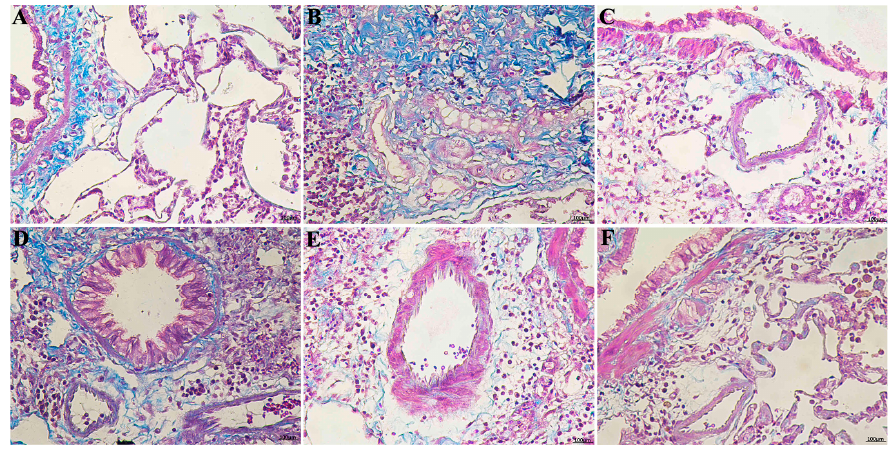
Figure 3. The Masson examinations of the lung tissues in rats (Bar = 100 μ m). ( A ) normal group; ( B ) model group; ( C ) PAG group; ( D – F ) are RRL groups treated with 125, 250 and 500 mg/kg, respectively.